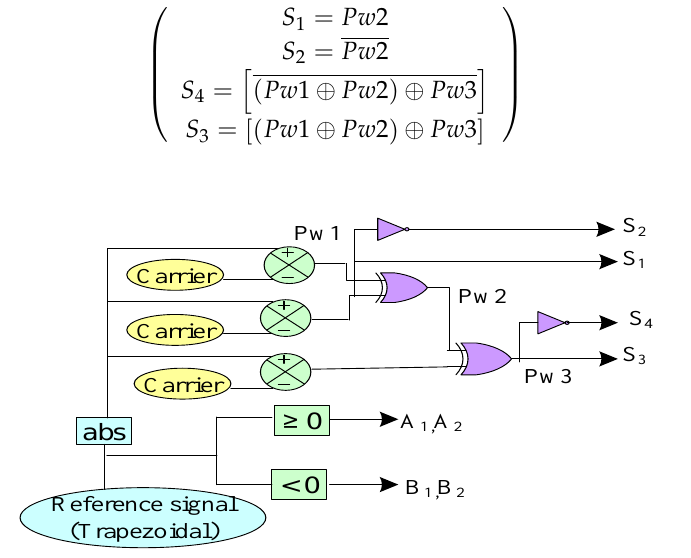
Figure 6. Logic circuits for pulse width modulation (PWM) generation.